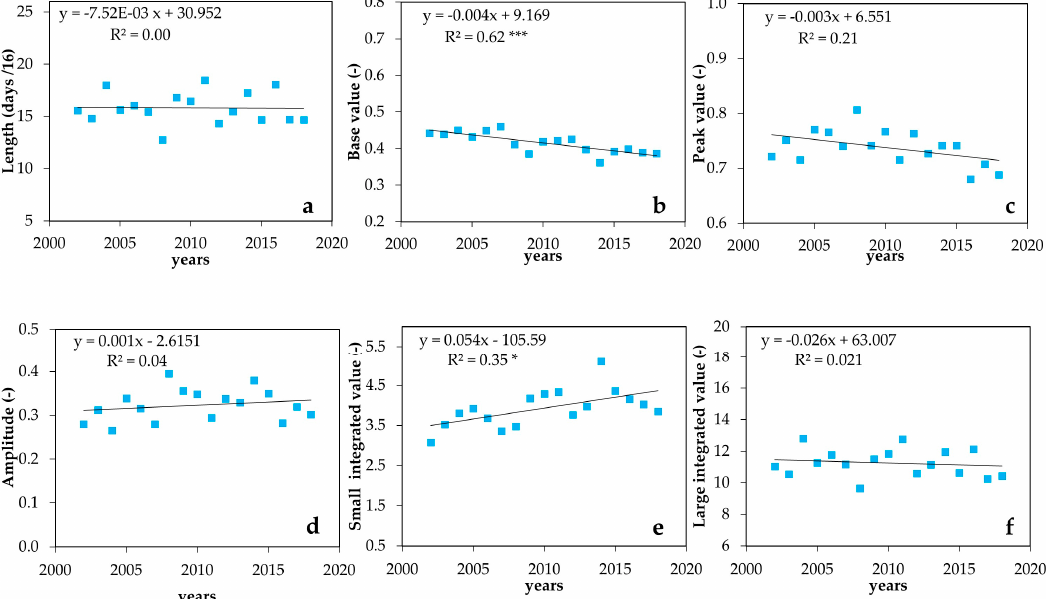
Figure 9. Seasonal parameters in CS2: ( a ) length value, ( b ) base value, ( c ) peak value, ( d ) amplitude value, ( e ) small seasonal integral and ( f ) large seasonal integral. The grey areas refer to the time interval when corrective measures have been implemented for facing CTV. Significant p- value ( p < 0.05, 0.01 and 0.001) are indicated with *, ** and ***, respectively.